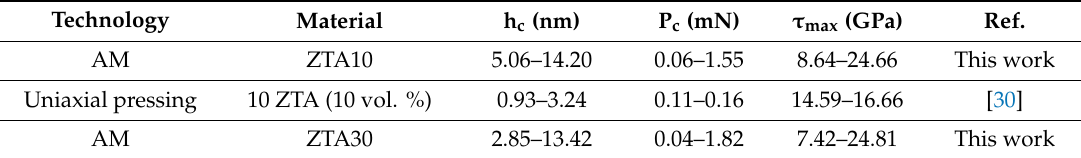
Table 1. Comparison of the variation ranges for ZTA ceramics manufactured by AM and conventional technology.